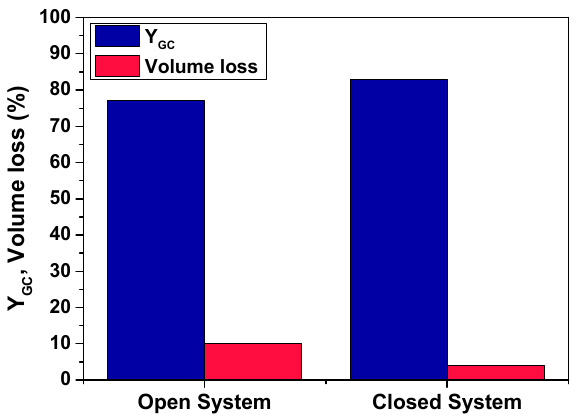
Figure 4. Yield to product and volume loss in reaction 1 under an open and a closed system using Eversa Transform. Conditions: T = 60 °C ; EC:Gly = 3:1; enzyme load: 3% w / w ; solvent: tert-butanol (30% v / v ) agitation speed: 400 rpm.